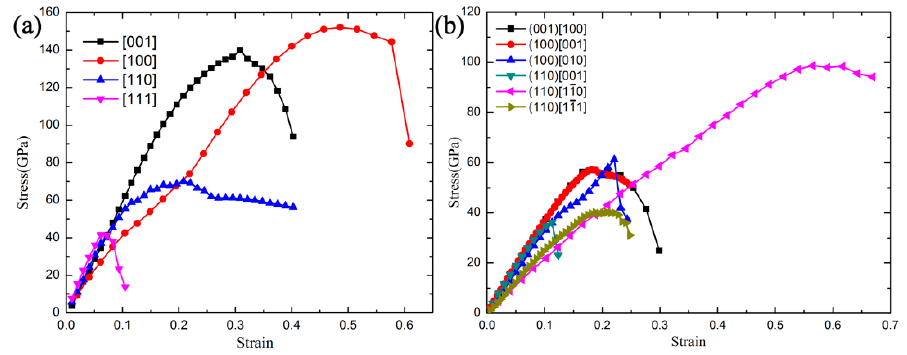
Figure 3. Calculated strain-stress relations for t- BC 2 in various tensile ( a ) and shear ( b ) directions. The shear stress responses in the (001), (100), and (110) planes were evaluated to search the easy cleavage plane of t- BC 2 . From Figure 3b, we can conclude that the ideal shear strengths show a high degree of anisotropy along the different shear directions, and the largest ideal shear strength in the (110)[110] shear direction (98.6 GPa) is 2.7 times larger than the lowest ideal shear strength in the (110)[001] shear direction (36.2 GPa). The minimum of the ideal shear strength is 13.0% lower than the tensile strength along the [111] direction, suggesting that the failure mode in t- BC 2 is dominated by the shear type. To obtain the fundamental mechanism of plastic deformation along the weakest shear direction, the bond lengths of d 1 and d 2 B–C bonds as a function of the shear strains in the (110)[001] direction are plotted in Figure 4. The development of the structure for t- BC 2 under shear deformation along this direction and the local bonding structure are also sketched by the inset a, b, and c in Figure 4. Clearly, the d 1 and d 2 B–C bonds are identical at equilibrium (shear strain γ = 0). Then, with the increase of shear strain, the d 1 B–C bond declines slightly but the d 2 B–C bond rises rapidly. Once the shear strain goes beyond the critical strain ( γ = 0.11279), the d 2 bond increases to 2.061 Å abruptly, indicating the breaking of the d 2 bond and the instability of the t- BC 2 structure. In